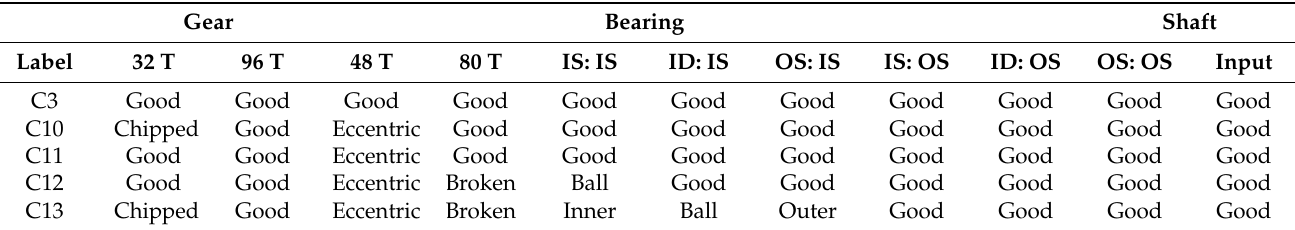
Figure 4. ( a ) Plan view of the experimental setup for the PHM09 dataset. ( b ) Healthy gear, gear with a missing tooth, and gear with a chipped tooth [51]. 3.1.3. COMFAULDA Data The COMFAULDA data [52] were acquired with a sampling frequency of 50 kHz for five seconds. The conditions included normal, horizontal misalignment, vertical misalign- ment, unbalance, unbalance with horizontal misalignment, unbalance with vertical misa- lignment, and horizontal misalignment with vertical misalignment at various misalign- ment levels of 0.50, 0.51, 1.00, 1.27, 1.4, 1.50, 1.78, 1.91, and 2.00 mm. The experimental rig was operated under different shaft rotating speeds of 12, 13, 40, 50, and 60 Hz while sub- jected to loads of 6, 10, 15, 20, 25, 30, and 35 g at various times. The data was acquired using both stud mounted piezometric and capacitive accelerometer. However, for this re- search data, acquired from piezometric accelerometer having acceleration measurement range of −50 g to 50 g with 0.27 to 10,000 Hz frequency range, and sensitivity of about 100 mV/g [53], alone was used. The shaft data with their corresponding labels that were used include a healthy shaft (C2), a shaft having unbalance with vertical misalignment (C14), a shaft having unbalance with horizontal misalignment (C15), and a shaft having vertical misalignment with horizontal misalignment (C16). Hence, in all, sixteen single and mul- tiple faulted shaft, bearing, and gear conditions from different machines were considered in this study. 3.2. Data Split After performing the preprocessing on the datasets, this was divided into training, validation, and test sets using either different runs of the specific machine or different operating conditions of the machine. The training set and validation set are made up of 450 images having a size of 224 × 224 pixels obtained with colour scale adjustment based on amplitude content at the signal processing phase. As shown in Table 3, the dataset is small and will be susceptible to overfitting. A major cause of low generalization and poor accuracy of deep learning models is training on small data. This makes it difficult to build an effective model that produces reliable results. In this work, this challenge was resolved by using different data augmentation techniques. The bias in the position of the input